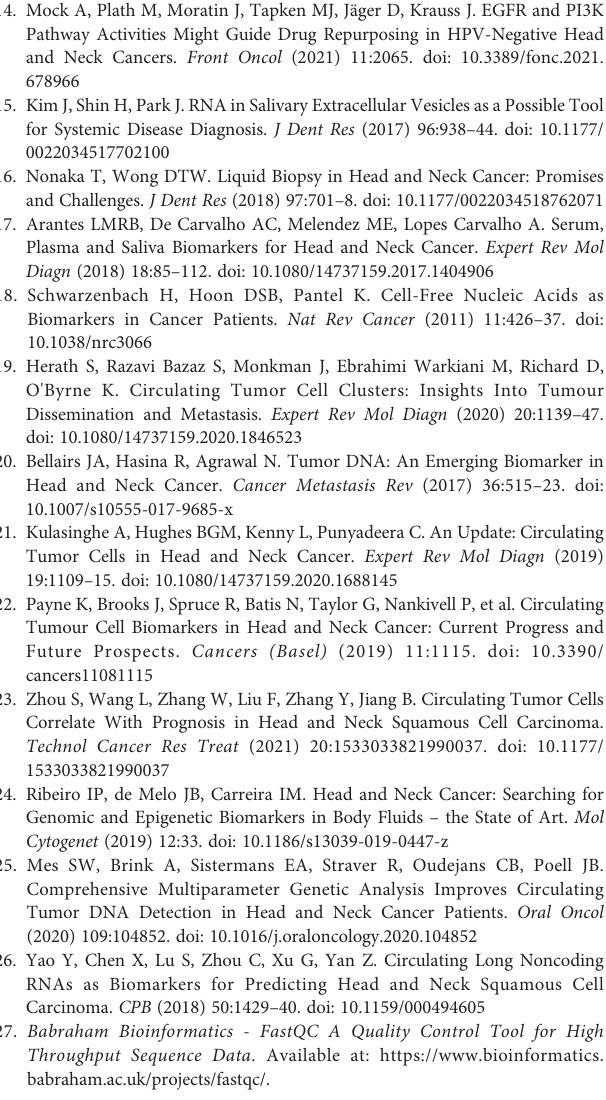
Supplementary Figure 1 | Heatmap representing all genes upregulated in cancer vs. healthy patients at baseline. Data are presented as z-scores, and clustering was performed using average linkage. Supplementary Figure 2 | Heatmap representing all genes upregulated in APG- treated cancer patients 24h post-treatment vs. pre-treatment. Data are presented as z-scores, and clustering was performed using average